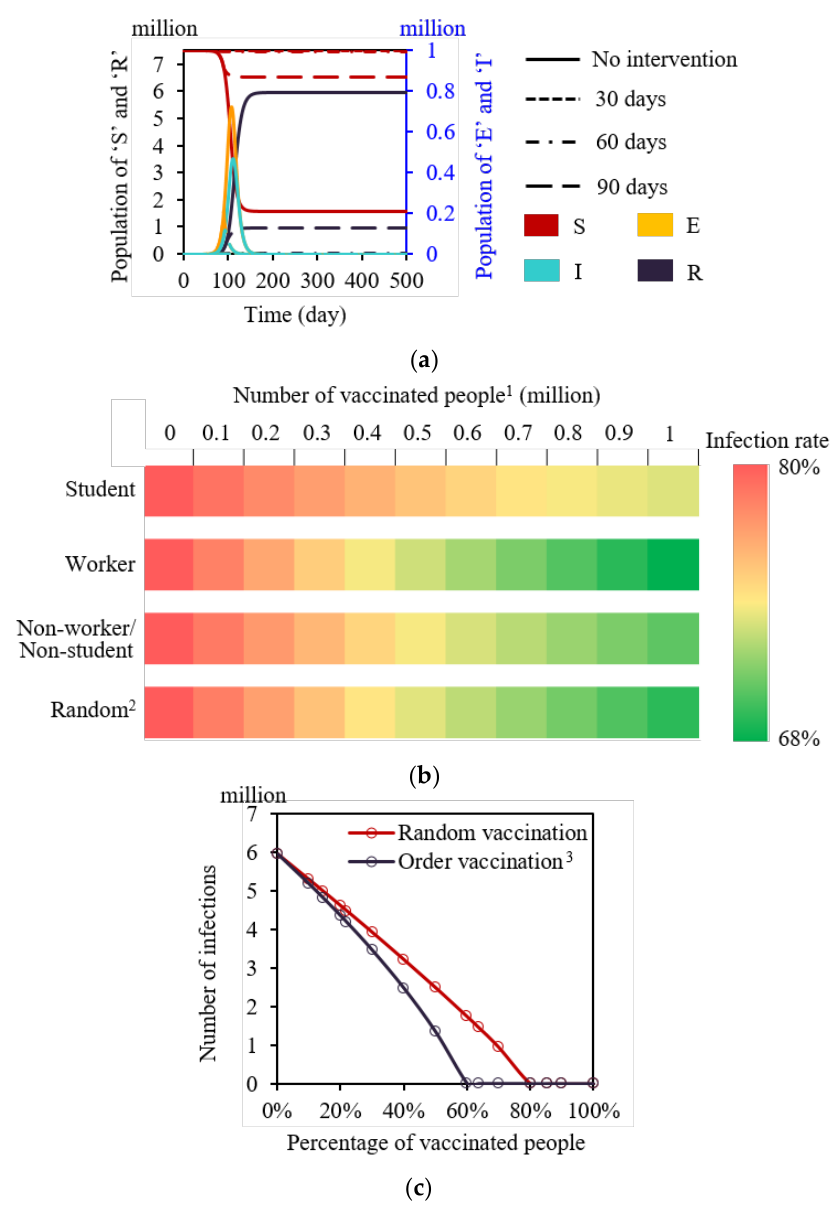
Figure 5. Vaccination strategy analysis. ( a ) Implementation time (assuming the proportion of vaccination was 100%). ( b ) Priority strategy for vaccination for three population groups if only 1 million people are vaccinated (interventions were assumed to be implemented on the 30th day after the first confirmed case). ( c ) Vaccination order if all residents (7.5 million) are vaccinated. 1 People who had successfully injected all vaccine doses. 2 Persons in each population group had the same probability to be vaccinated. When 1 million residents are vaccinated, the ratios of students, workers, and non-students/non-workers to be vaccinated are 14.6%:63.5%:21.9%, respectively. 3 Workers were prioritized to be vaccinated, followed by non-workers/non-students and students.